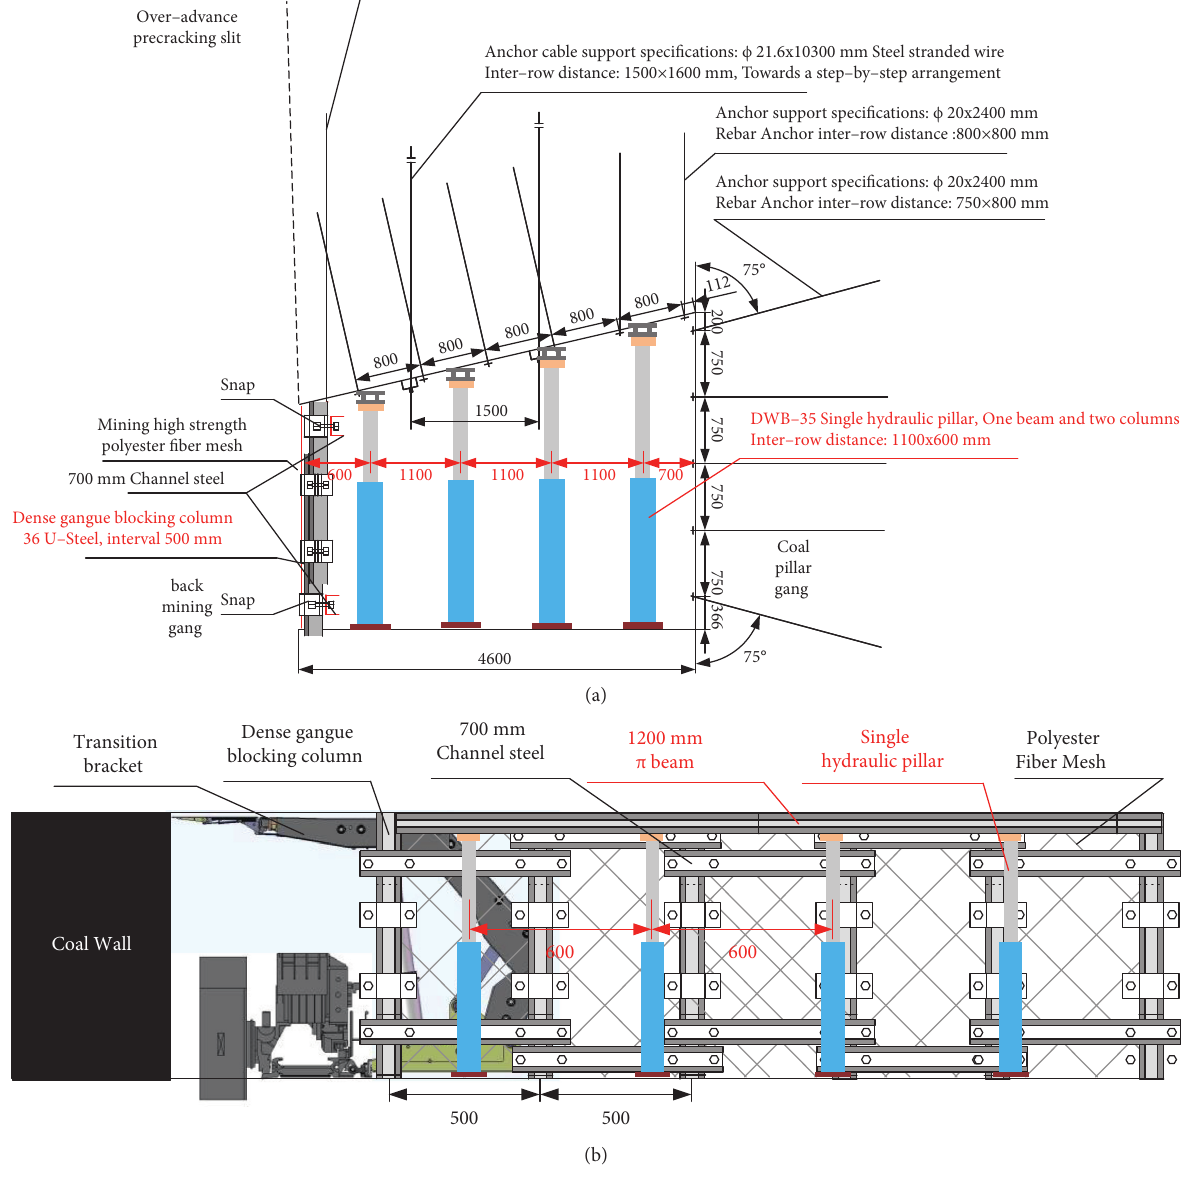
Figure 10: Section and side view of lagging temporary